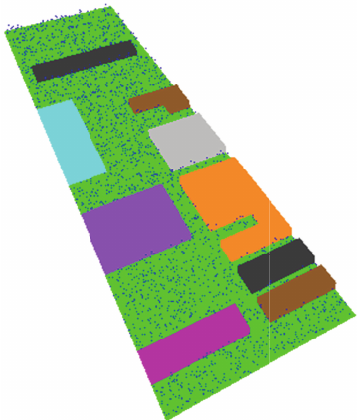
Figure 7: The visualization result of dust evolution in virtual